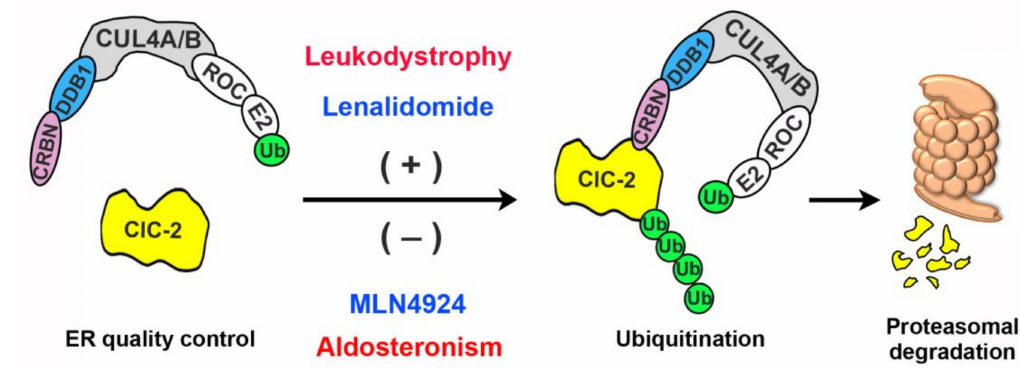
Figure 12. Schematic model of endoplasmic reticulum (ER)-associated degradation of ClC-2. In this schematic diagram of the regulation of ClC-2 proteostasis by ER quality control, the sca ff old protein CUL4A / B forms a protein complex with the adaptor protein DDB1 and the substrate receptor protein CRBN. CUL4A / B also interacts with the RING-finger protein ROC, which in turn recruits the E2 ubiquitin conjugating enzyme (E2) that transfers ubiquitin (Ub) for covalent linkage to a substrate protein. We propose that, through the direct interaction between CRBN and ClC-2, the CUL4A / B-DDB1-CRBN E3 ubiquitin ligase complex catalyzes the ubiquitination of misfolded ClC-2 proteins. Ubiquitinated ClC-2 is subsequently targeted for proteasomal degradation. Loss-of-function, leukodystrophy-causing mutations may instigate substantial protein misfolding, leading to enhanced degradation of mutant ClC-2proteins. Incontrast, gain-of-functionaldosteronism-causingmutationsappeartofacilitateprotein stability, thereby reducing proteasomal degradation of mutant ClC-2 channels. The CRBN-targeting immunomodulatory drug lenalidomide e ff ectively promotes, whereas the cullin E3 ligase inhibitor MLN4924 significantly attenuates, proteasomal degradation of both ClC-2 WT and disease-associated mutant